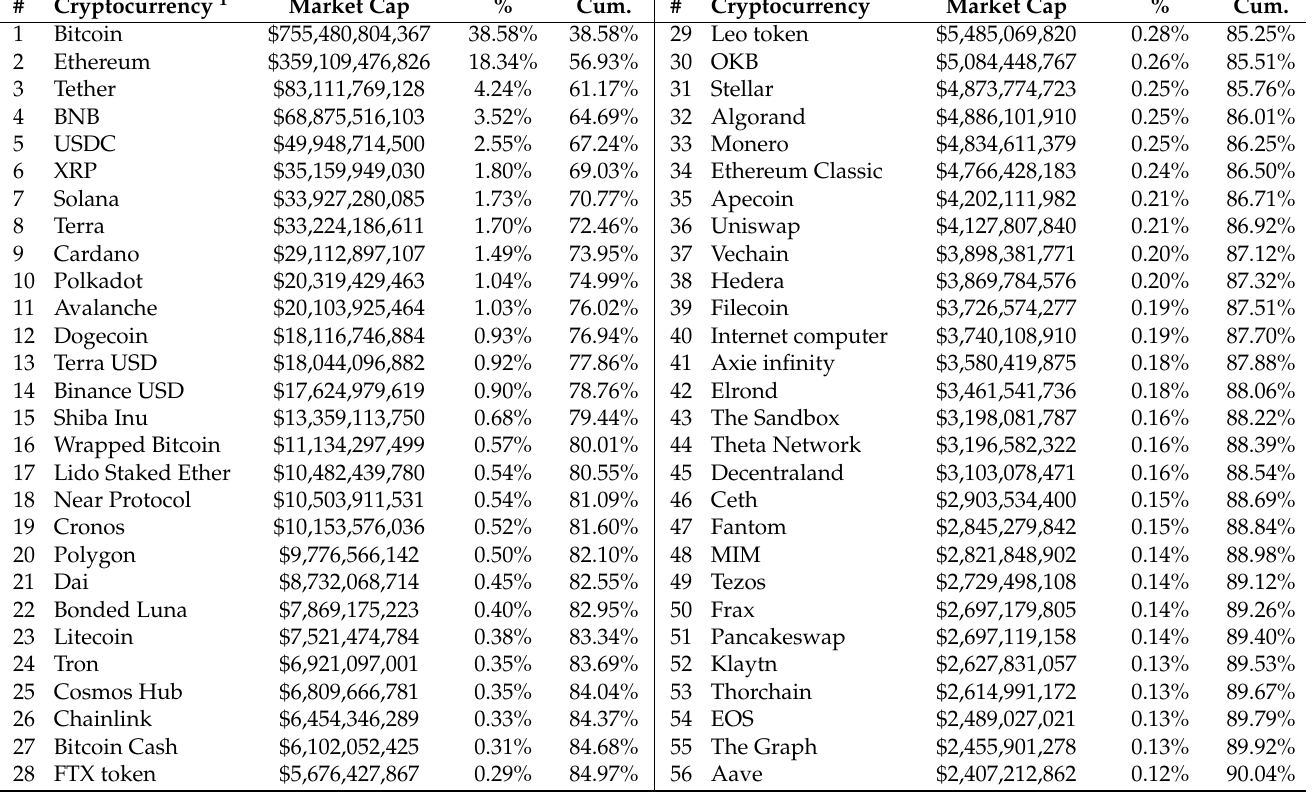
Table 1. The 56 largest cryptocurrencies, by market capitalisation (CoinGecko